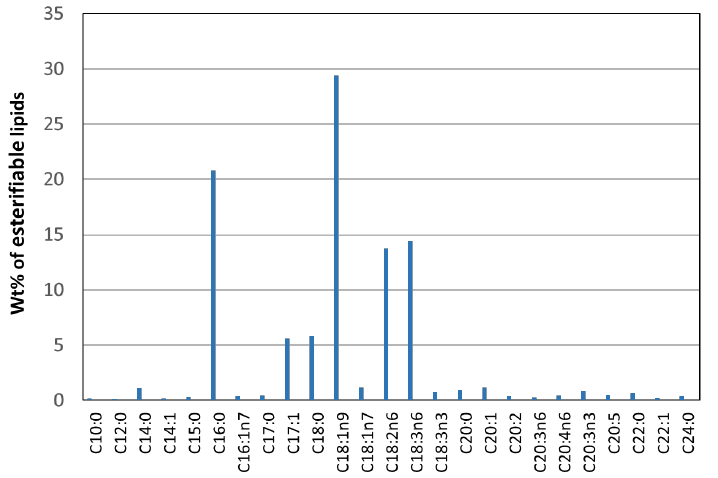
Figure 8. Lipid profile of Coelastrella sp.